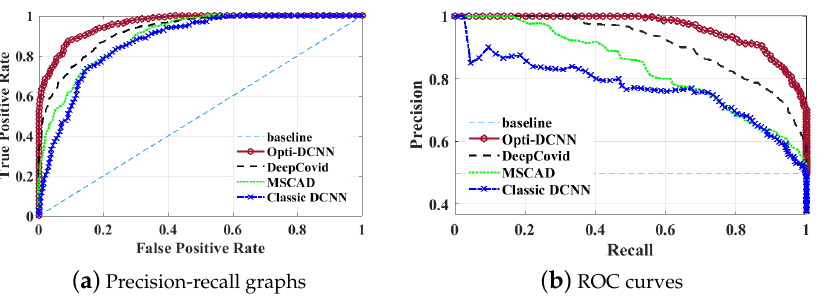
Figure 11. TPR/FPR graphs ( a ) and ROC curves ( b ) for OptiDCNN and other benchmark